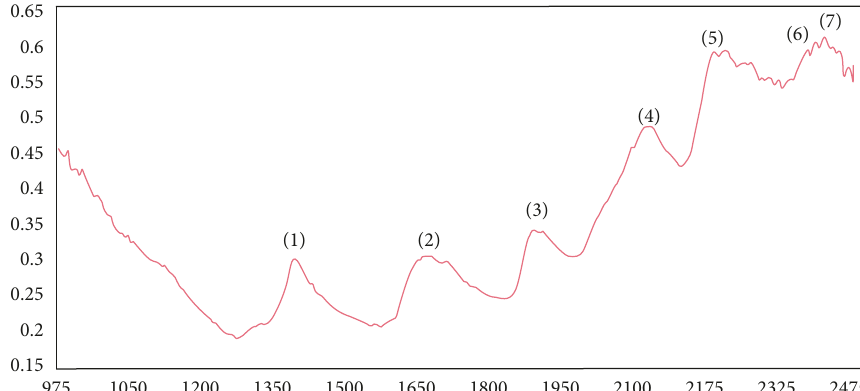
Figure 7: The average spectrum for the red area (knots) on the ThermoD surface in Figure 6 (numbers related to Table